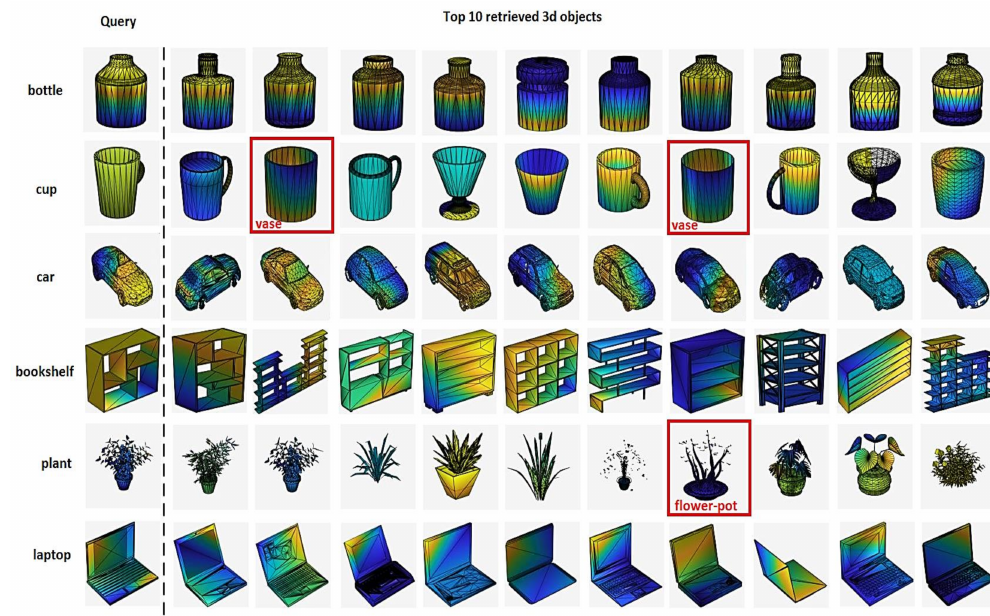
Figure 8. The top 10 retrieved objects for the ModelNet40